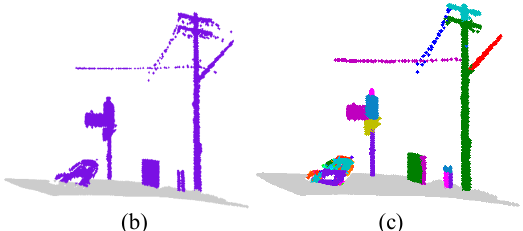
Figure 5. (a) Dataset 2 (b) ground and non-ground surface points from the proposed algorithm (g) segmentation results